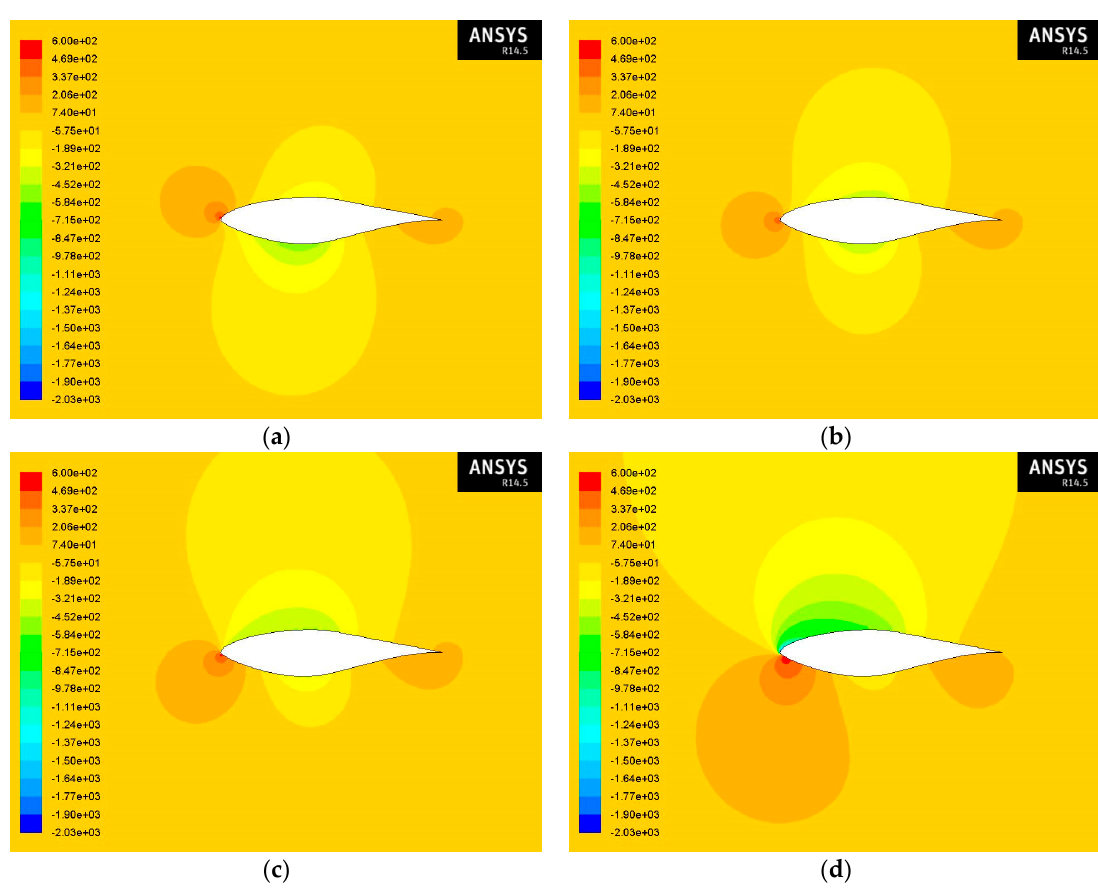
Figure 9. Contours of static pressure at ( a ) − 3°; ( b ) 0°; ( c ) 3°; and ( d ) 9° angles of attack at Re = 1 × 10 6 with the realizable k– ε turbulence model for and S809 airfoil for air-sand particle two-phase flow and 10% concentration of sand particles in the air.